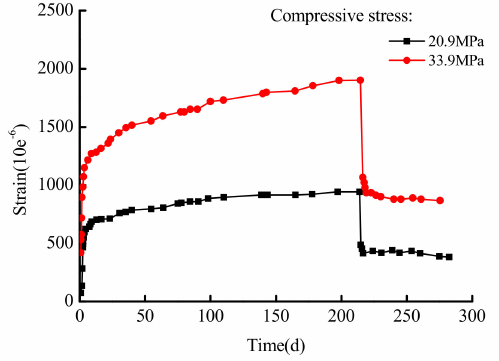
Figure 3. The curve of the concrete creep tests under di ff erent